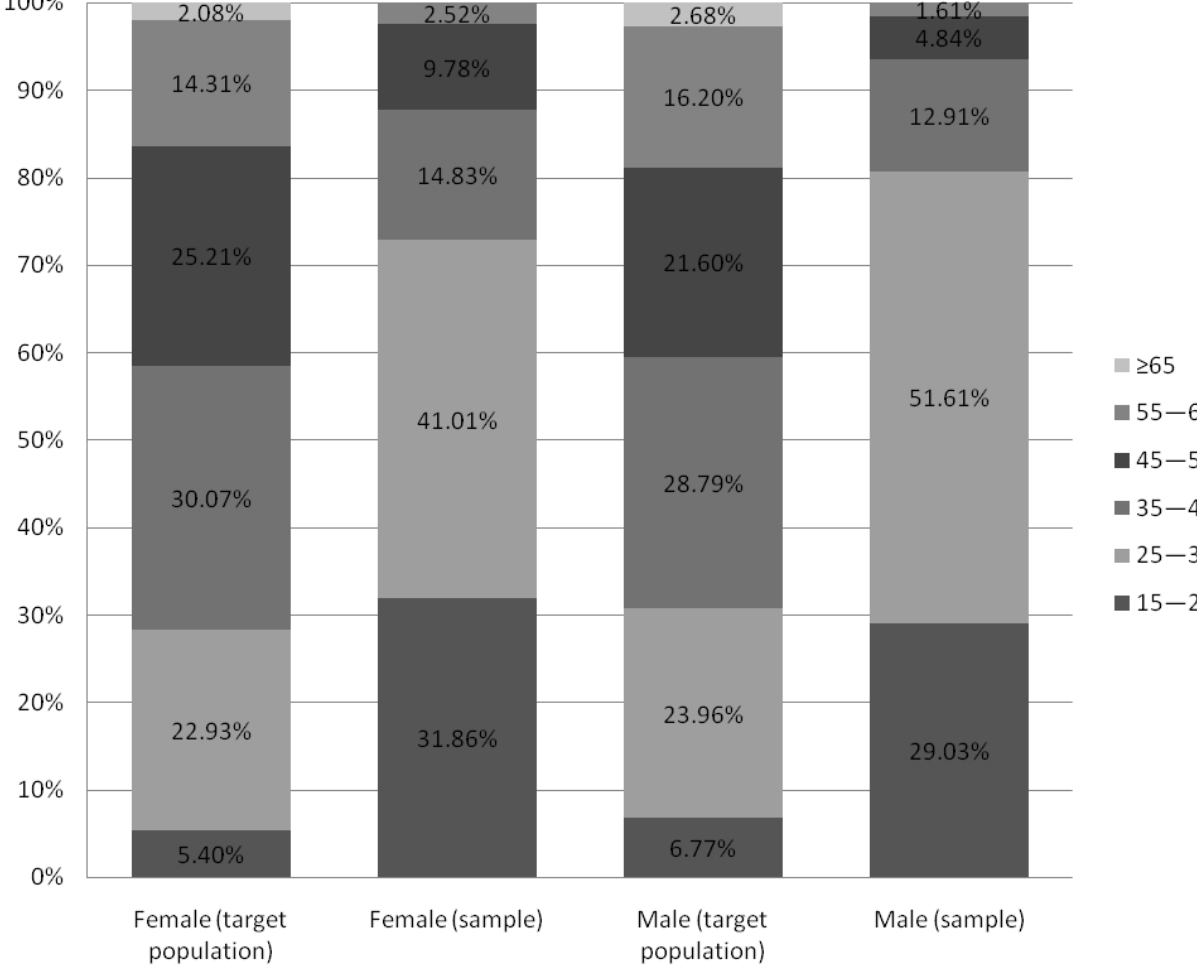
Figure 4. Chart presenting place of residence differences between study groups (based on Statistic Poland). Note: Status report on target Polish working population in the 4th quarter of 2020 according to “Yearbook of Labour Statistics 2021”; Statistics Poland